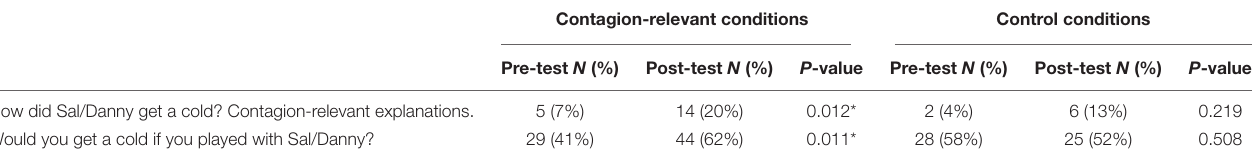
TABLE 3 | Pre- to post-test comparisons for cold knowledge across the contagion-relevant and control